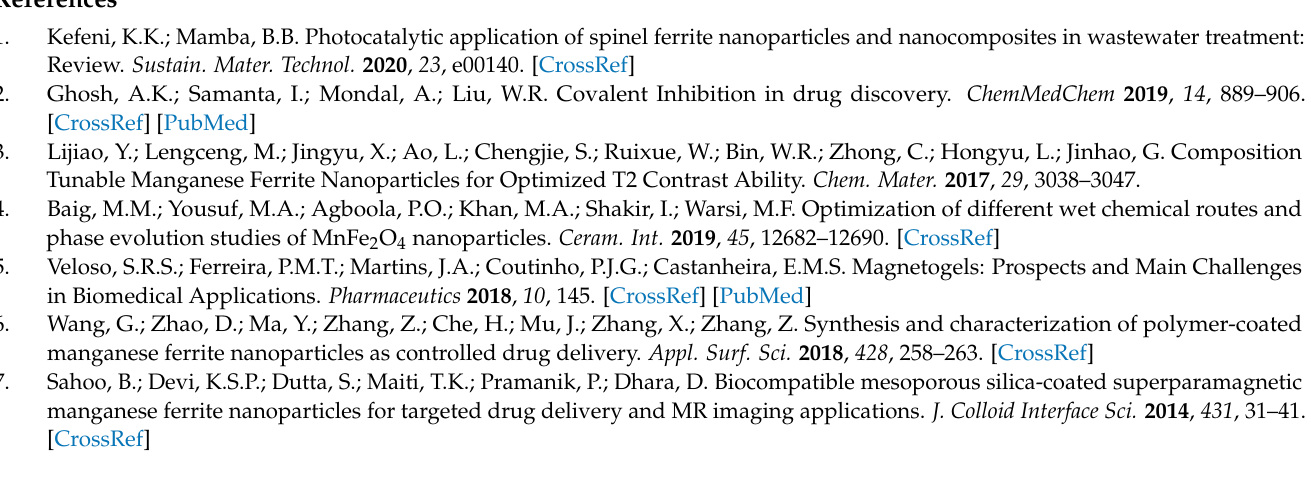
MnFe 2 O 4 /silica/cisplatin and MnFe 2 O 4 /GO/cisplatin. (B) Treatment concentrations and statis- tical analysis. Different concentrations were used for MnFe 2 O 4 and cisplatin to reflect the actual concentration adsorbed on the nanocomposite. For details, please see the Materials and Methods section. n = 3 independent experiments. Dashed line represents untreated cells, control. * p < 0.05; ** p < 0.01; *** p < 0.001; **** p < 0.0001 versus control using two-way ANOVA with Dunnett’s post hoc testing; Figure S5 : (A) MTT cell viability assay on HEK293 cell line. Cells were treated with the following conditions for 48 h: MnFe 2 O 4 , silica, GO, Cisplatin, MnFe 2 O 4 /silica/cisplatin and MnFe 2 O 4 /GO/cisplatin. (B) Treatment concentrations and statistical analysis. Different concen- trations were used for MnFe 2 O 4 and cisplatin to reflect the actual concentration adsorbed on the nanocomposite. For details, please see the Materials and Methods section. n = 3 independent experi- ments. Dashed line represents untreated cells, control. * p < 0.05; ** p < 0.01; *** p < 0.001; **** p < 0.0001 versus control using two-way ANOVA with Dunnett’s post hoc testing; Figure S6 : HCT116 cells were treated with 0.05 mg/mL of MnFe 2 O 4 /silica/cisplatin and MnFe 2 O 4 /GO/cisplatin and its equivalent concentration of cisplatin (0.00225 mg/mL for details, please check the Materials and Methods section). Cells were treated for 6 h (A), and 24 h (B) and then stained with Annexin V (AV), Propidium Iodide (PI), and Hoechst. n = 5 independent